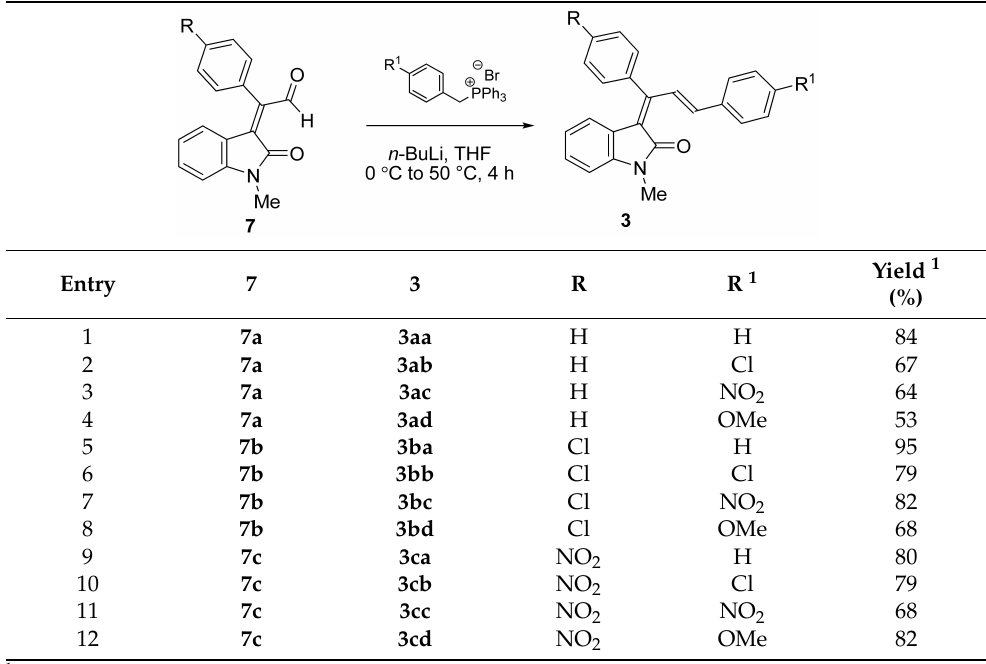
Table 2. Substrate scope of the Wittig